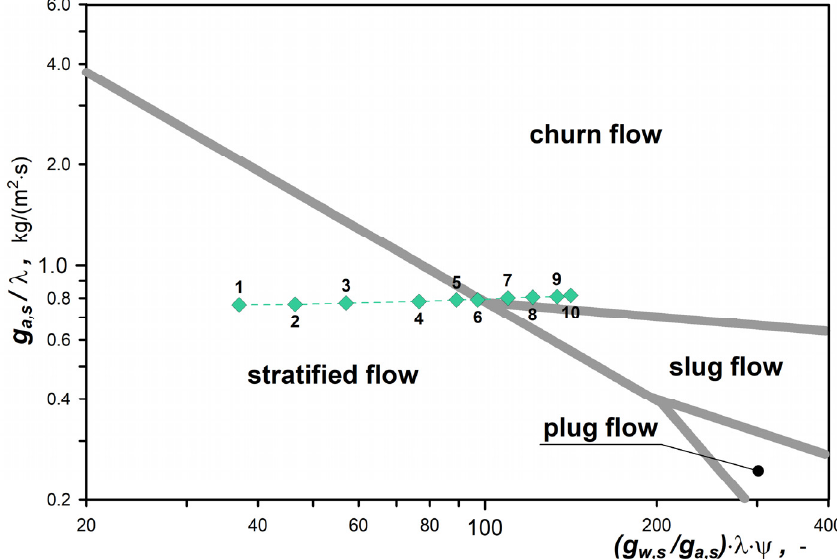
Figure 9. Section of a map with flow patterns identified in the study by [37] with marked meas- urement series representing the conditions of the current research. series representing the conditions of the current research.